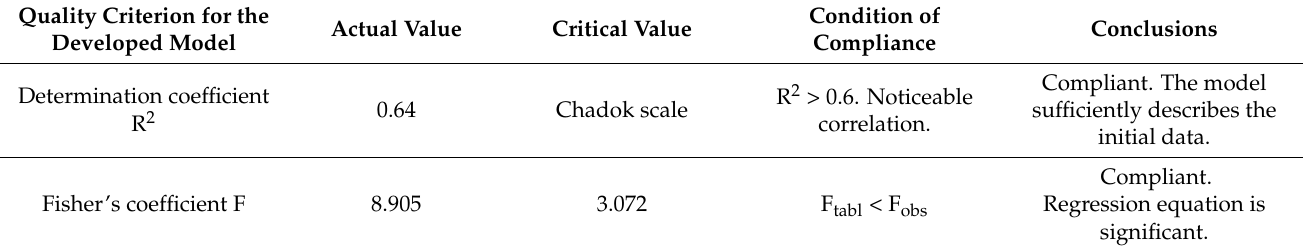
Table 5. Elasticity coefficients of a